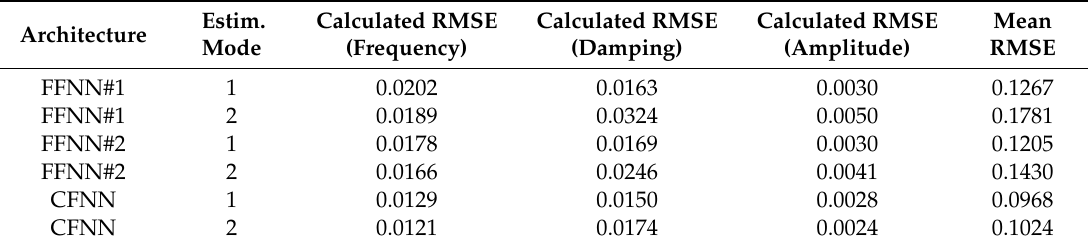
Table 4. Calculated root-mean-square error (RMSE) for the different ANN architectures of validation scenario